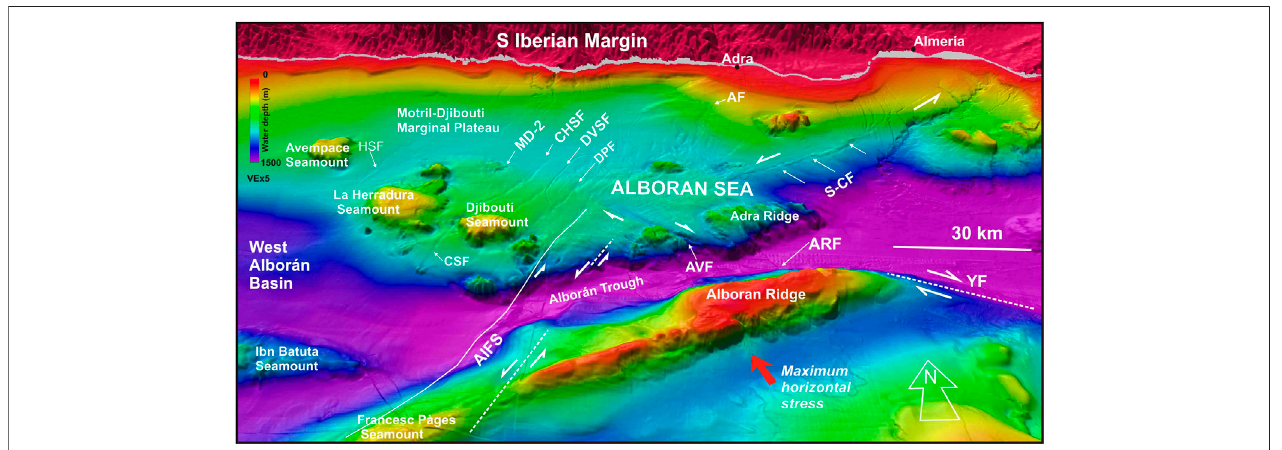
FIGURE 7 | Three days multibeam bathymetry of the Alborán Sea showing the main active submarine faults. See location in Figure 1A . AF: Adra Fault; AIFS: Al Idrissi Fault System; ABR: Alboran Ridge Fault; AVF: Averroes Fault; CSF: Calahonda Sound Fault; DVSF: Djibouti Seamount Sound Fault; DPF: Djibouti Passage Fault;